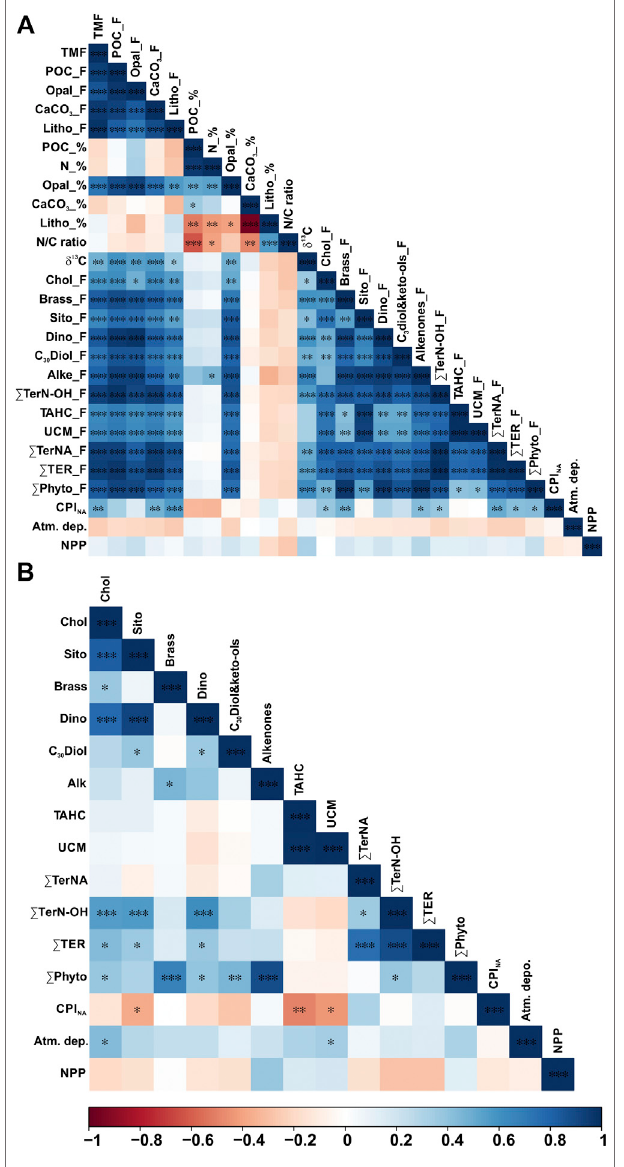
FIGURE 4 | Pearson correlation heatmap matrix with signi fi cance level expressedbyasterisks(*** p -value ≤ 0.001,** p -value ≤ 0.05,* p -value ≤ 0.1)of A) fl uxes (F) and percentages (%) of bulk parameters, fl uxes of lipid biomarkers, CPI NA , total atmospheric deposition, and net primary production, and (B) POC-normalized concentrations of lipid biomarkers and CPI NA , total atmospheric deposition, and net primary production. Positive correlations are displayed in blue and negative correlations in red color. Color intensity are proportional to the correlation coef fi cients.